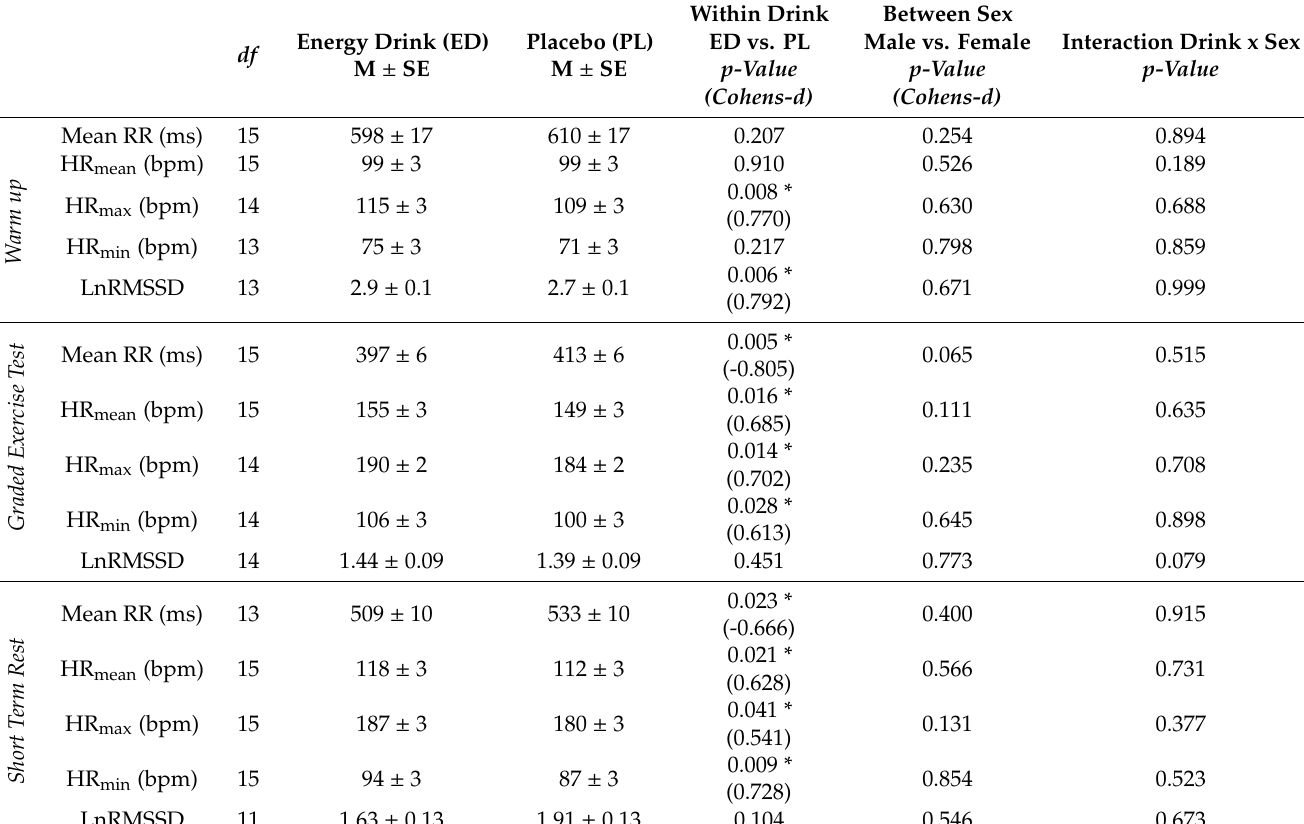
Table 2. Comparison of time domain parameters during warm up, graded exercise test, and short-term recovery 15 min post